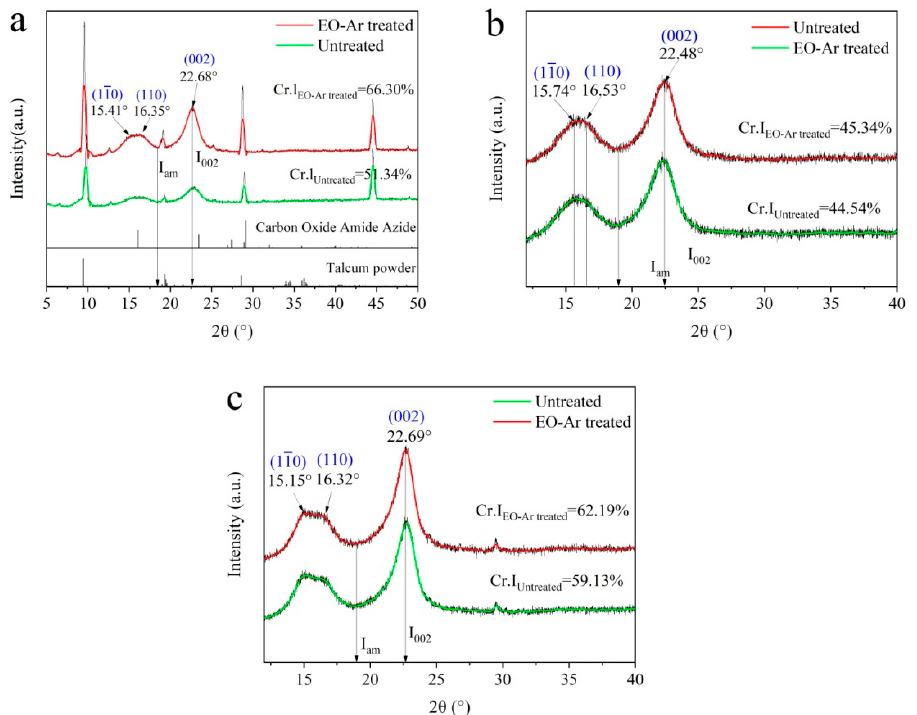
Figure 5. XRD patterns of paper samples untreated and EO-Ar treated after artificial accelerated aging. ( a ) sample 1, ( b ) sample 2, ( c ) sample 3. Table 5. Analysis of methanol extract for untreated sample 4.